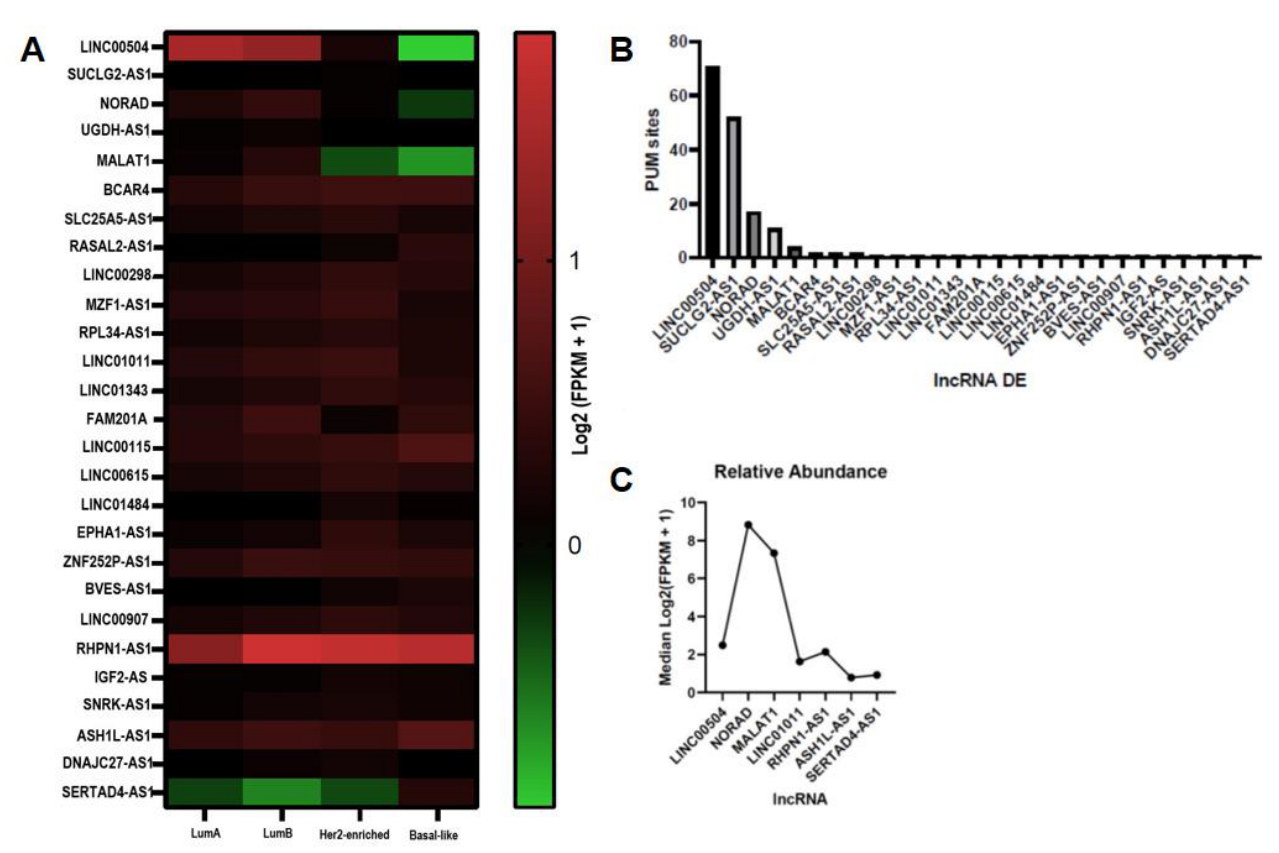
Figure 1. LncRNA with sites for PUMILIO differentially expressed in BRCA. Legend : ( A ) Heatmap representation of the activity of expression networks of 27 lncRNAs in breast cancer molecular subtypes. According to this metric, differentially expressed positive (above the median—log2FC cutoff) ( p < 0.05) are in red and differentially expressed negative (below the median—log2FC cutoff) ( p < 0.05) are in green. Samples are arranged in the columns of the heatmap and categorized according to the annotation bar on the side of the graph ( − 0.92 to 1.8). The TCGA BRCA cohort samples were classified according to molecular classification into Lum A ( n = 560), Lum B ( n = 207), Her2-enriched ( n = 82), and Basal-like ( n = 190). ( B ) Number of sites for PUMILIO in 27 differentially expressed lncRNAs in breast cancer (BRCA). ( C ). Relative abundance of seven lncRNA with detectable expression—median Log2(FPKM + 1) (Fragments Per Kilobase Million) in BRCA samples from the same TCGA BRCA cohort.